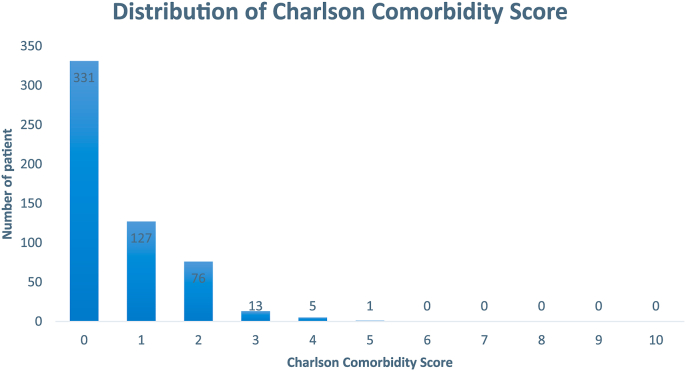
Histogram showing distribution of Charlson Comorbidity Score across 576 patients.